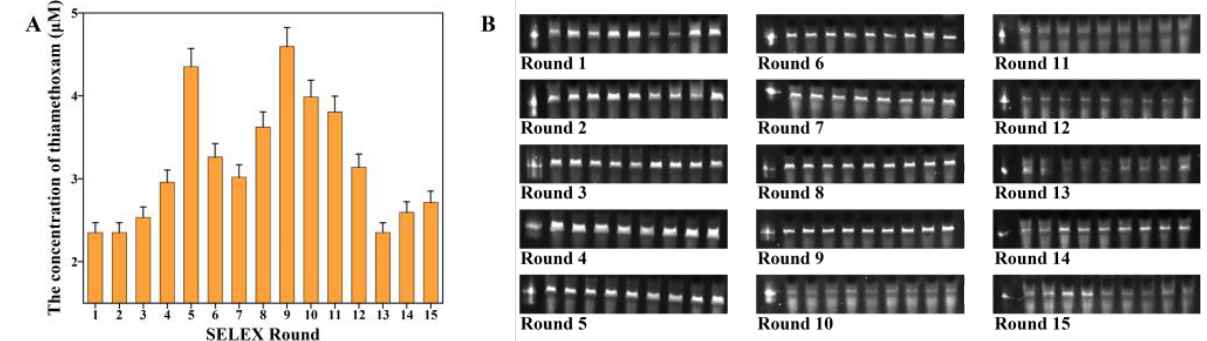
Figure 3. ( A ) The concentration of eluted thiamethoxam in each round. ( B ) Result for each round of